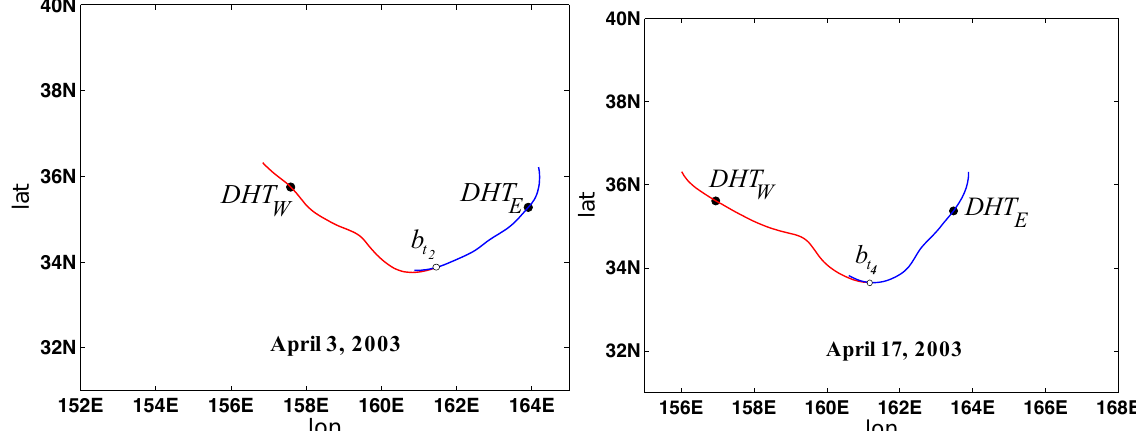
Fig. 21. Boundaries at days 3 April 2003 and 17 April 2003 constructed from a (finite length) segment of the unstable manifold of DHT W and a (finite length) segment of the stable manifold of DHT E . The boundary intersection points are denoted respectively by b t (Figure taken from Mendoza et al.,